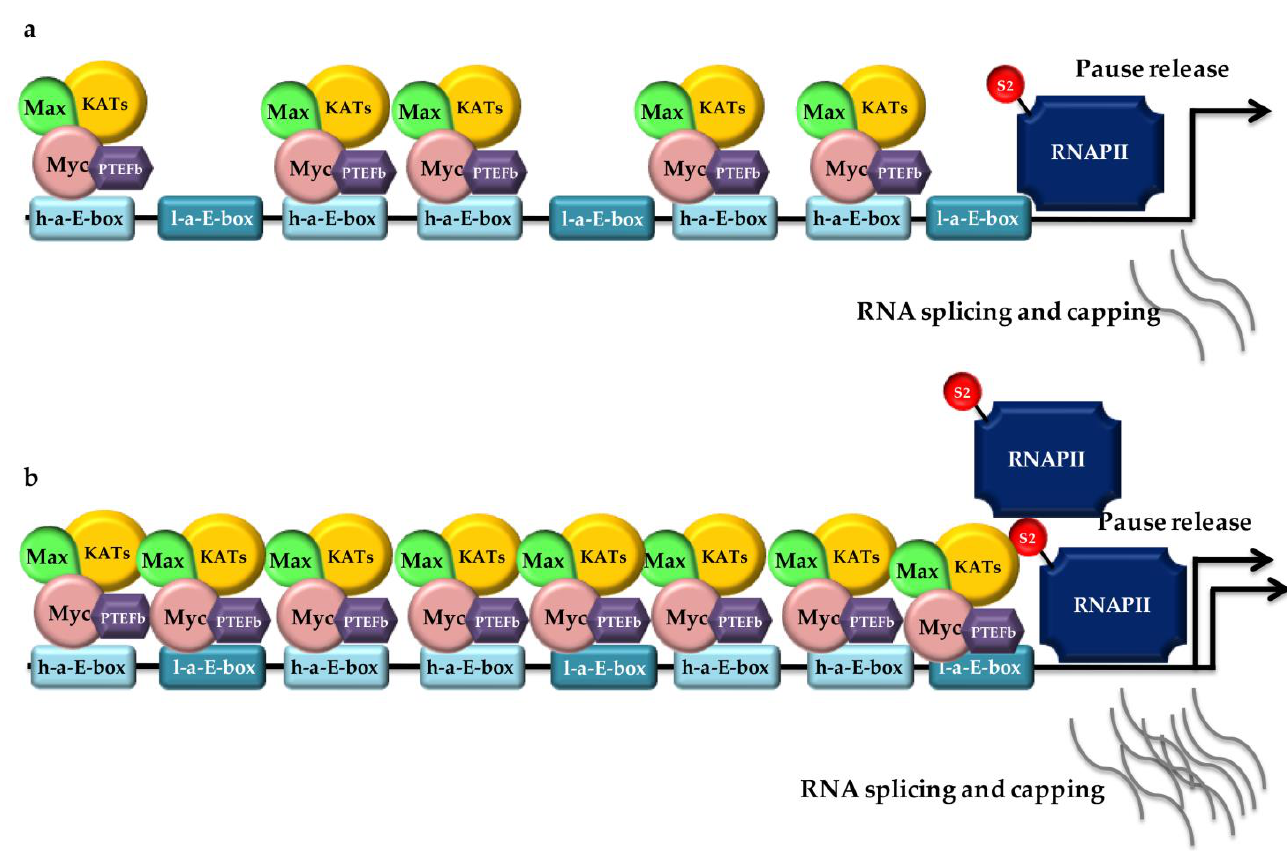
Figure 2. Myc regulation of gene transcription in healthy and cancer cells. Schematic representation of abundancy-dependent Myc binding at target promoters. ( a ) In healthy cells, Myc/Max and coregulators preferentially bind to high-affinity E-boxes (h-a-E-box). By inducing both the opening of chromatin through histone acetylation and RNAPII pause and release via PTEFb-dependent phosphorylation of Ser2 on RNAPII, Myc/Max heterodimers tune the transcription, splicing, and RNA capping of genes pivotal to cellular homeostasis. ( b ) In overexpressing Myc cancer cells, Myc/Max heterodimers also invade low-affinity binding sites (l-a-E-box) and push transcription, leading to the execution of aberrant gene expression